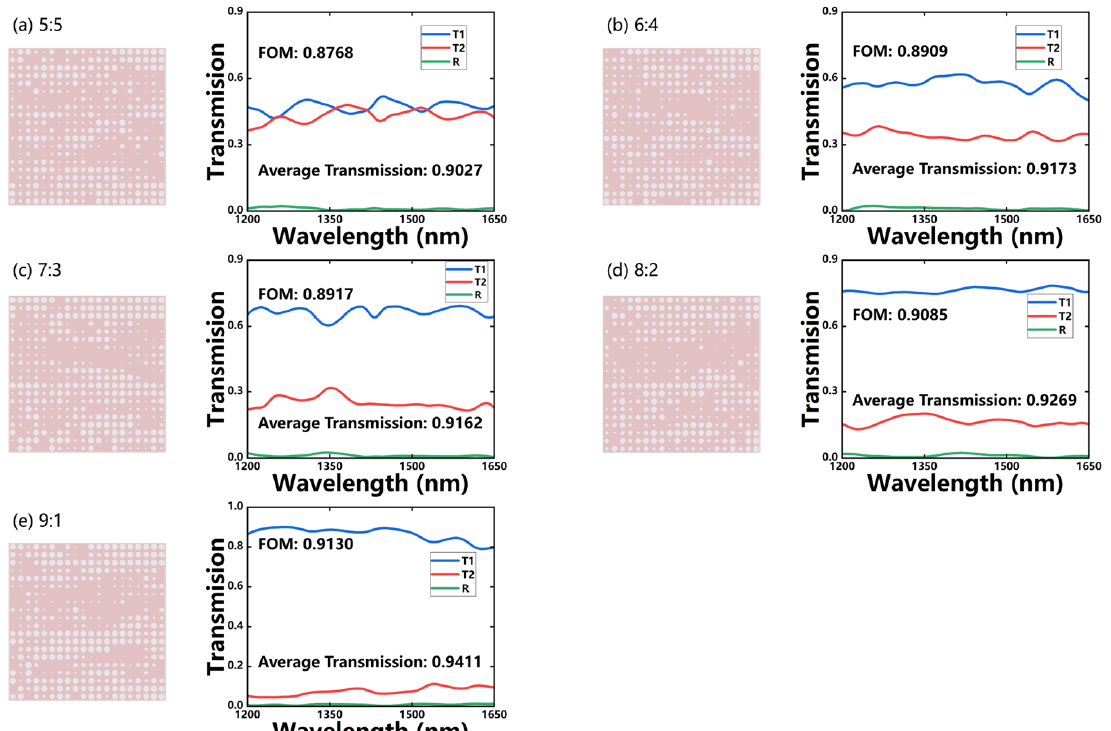
Figure 10. The hole distribution of the designed MMI and their transmission spectra for ( a ) 5:5, ( b ) 6:4, ( c ) 7:3, ( d ) 8:2, and ( e ) 9:1 target splitting ratios, from the SAGAN-sim model.